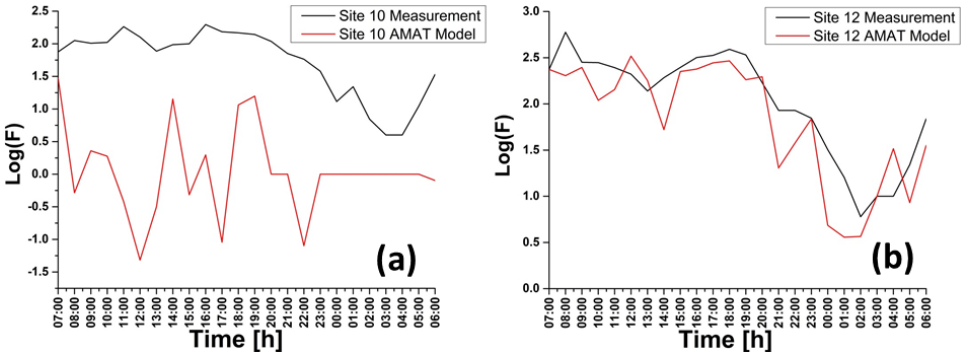
Figure 8. Comparison of traffic flow measurements (black lines) with the model predictions (red lines) for: ( a ) Site 10 ( g 1 ), ( b ) Site 12 ( g 2 ) [86]. (With permission from